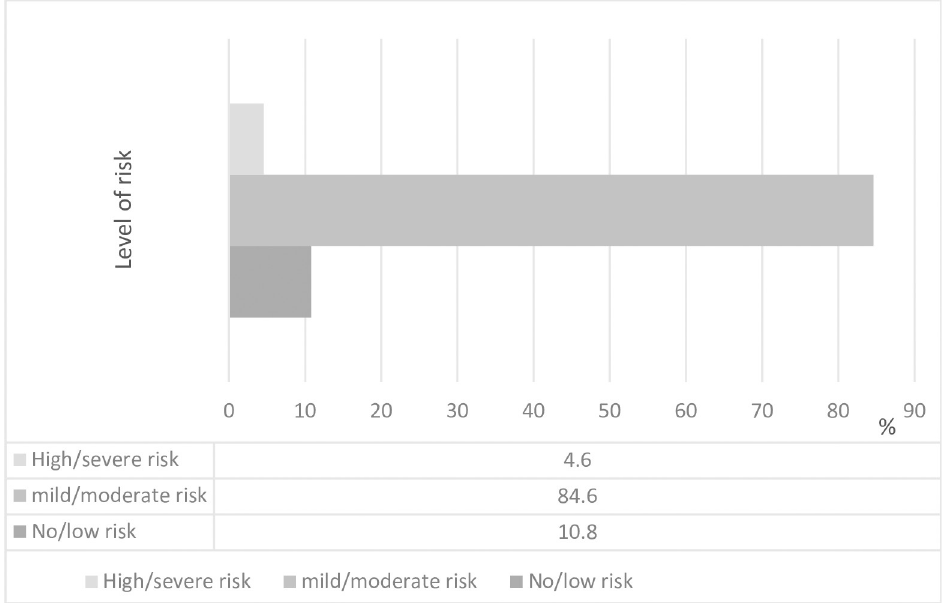
Fig 1. Frequency distribution of the level of risk caused by the job factors among the respondents (N = 130).